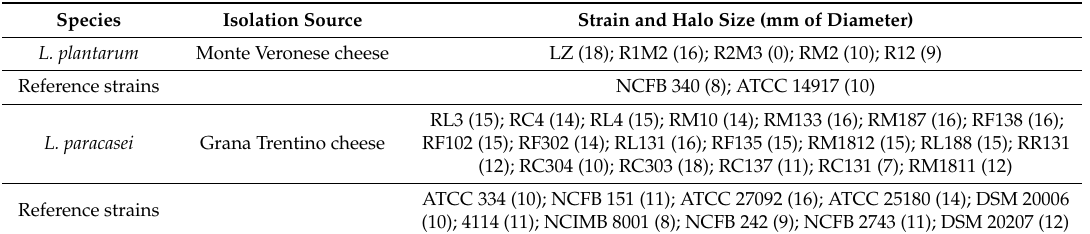
Table 1. Bacterial strains tested for sensitivity to nisin in this study with respective halo sizes observed in the deferred agar spot test with the nisin producer L. lactis subsp. lactis DSM 20729.